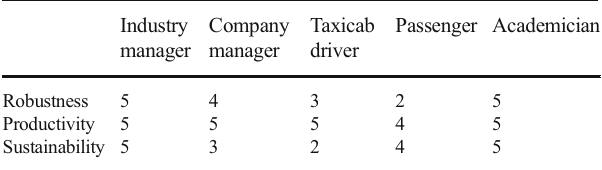
Table 3 Weights of different decision-makers Industry Company manager